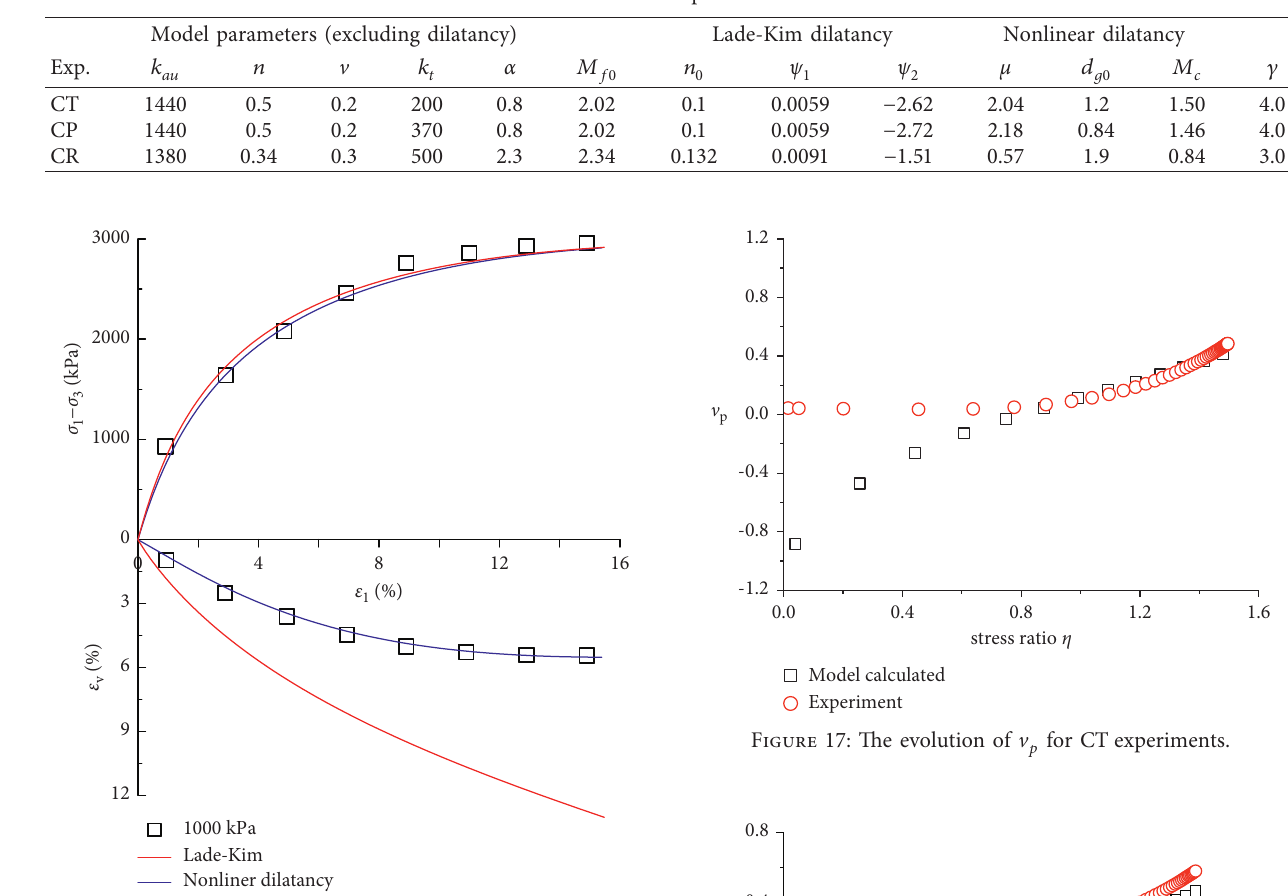
Figure 17: The evolution of v